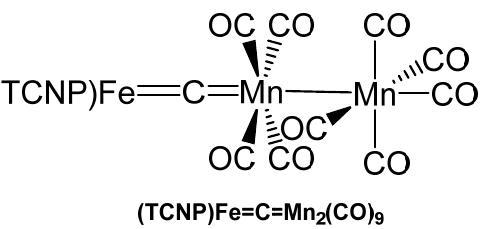
Figure 40. Structural representation of the Fe = C = Mn carbido complex (TCNP)Fe = C = Mn 2 (CO) 9 .